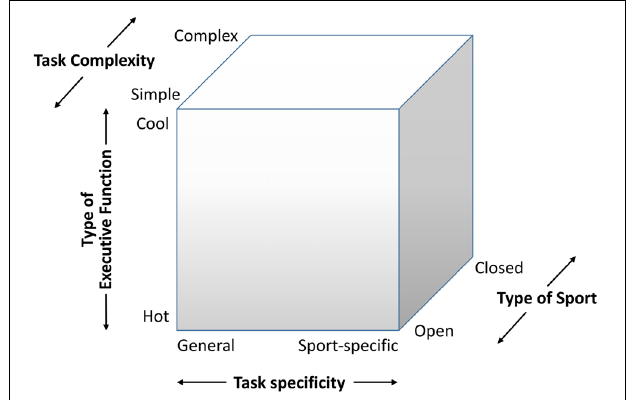
FIGURE 8 | Proposed four-dimensional classification multicomponent system to examine expertise effects in